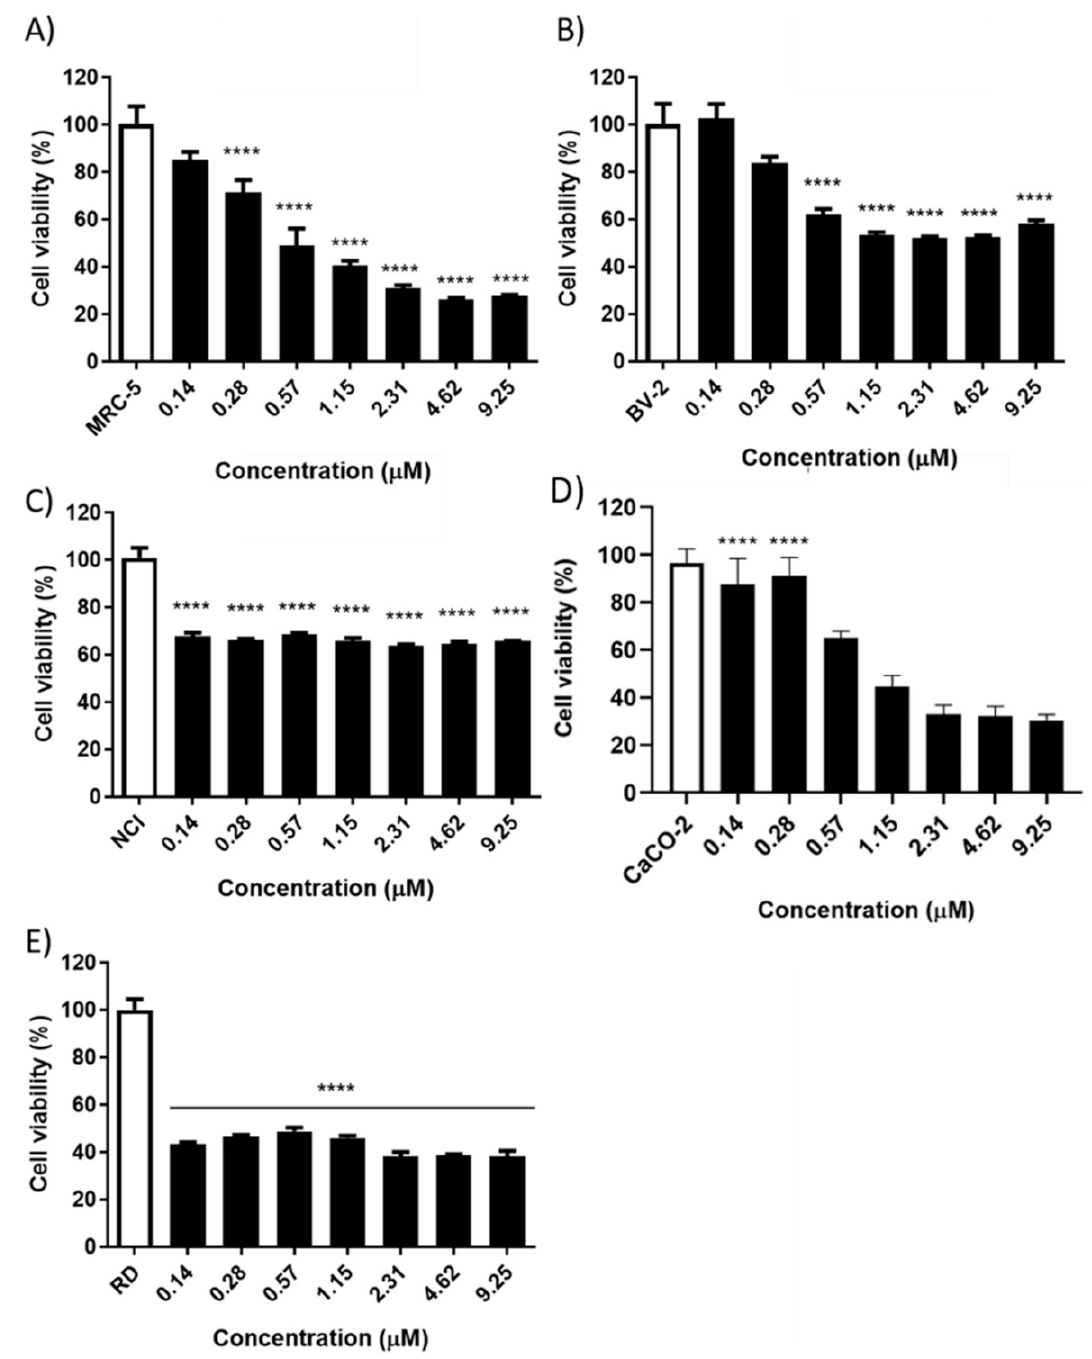
Figure 3. Assay of cellular viability investigating the effects of BmPLA2 on cancer and healthy cells. ( A ) Healthy human fibroblast cell line (MRC-5); ( B ) Microglia cell line; ( C ) Mucoepidermoid carcinoma of the lung (NCI-H292); ( D ) Human colorectal cancer cell line (Caco-2); ( E ) Human rhabdomyosarcoma cells (RD). All cell lines were treated with BmPLA2 (9.25, 4.62, 2.31, 1.15, 0.57 and 0.28 µ M) for 24h. The viability was determined using MTT reagent. All data were expressed as mean ± S.E.M and procedures were carried out in duplicate. **** means differences between the groups were considered statistically